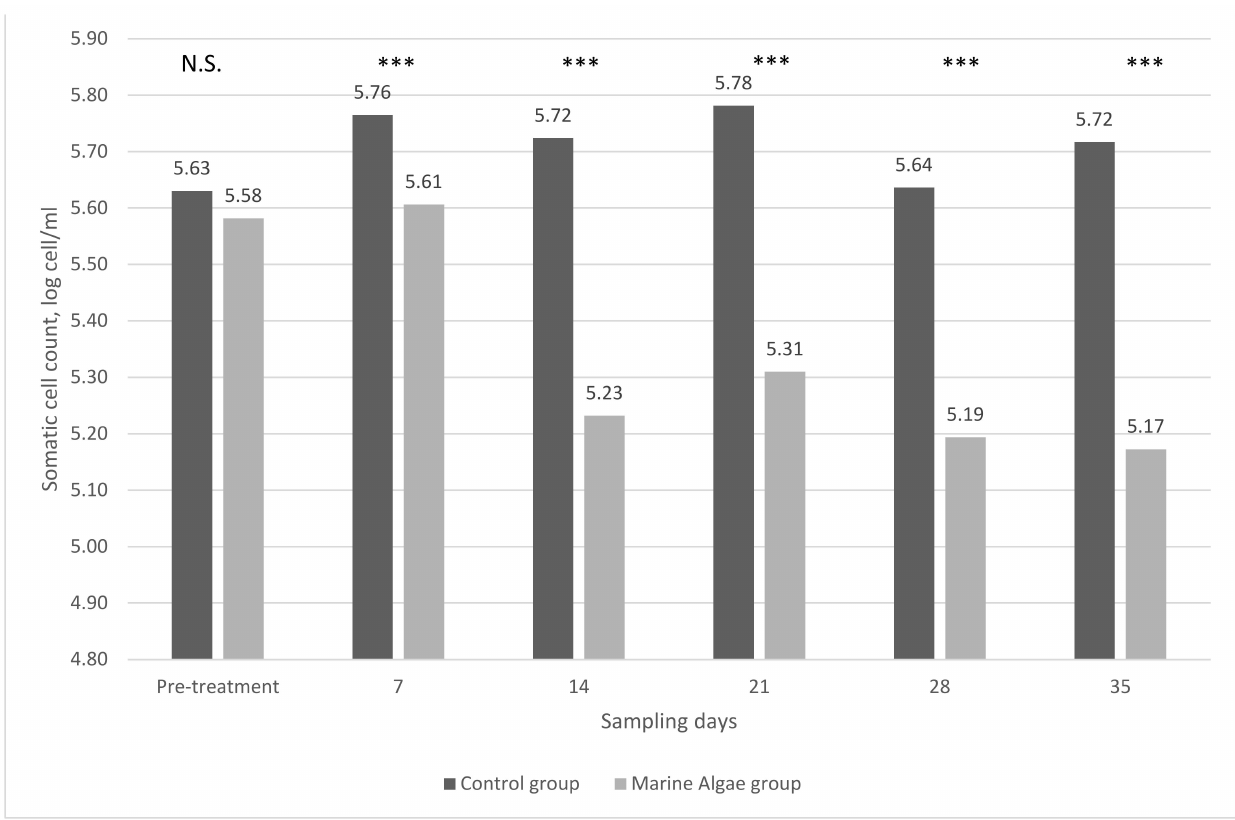
Figure 1. Somatic cell counts of goat milk from different feeding treatments (each group and sampling day n = 14). N.S.—not significant; ***— p <